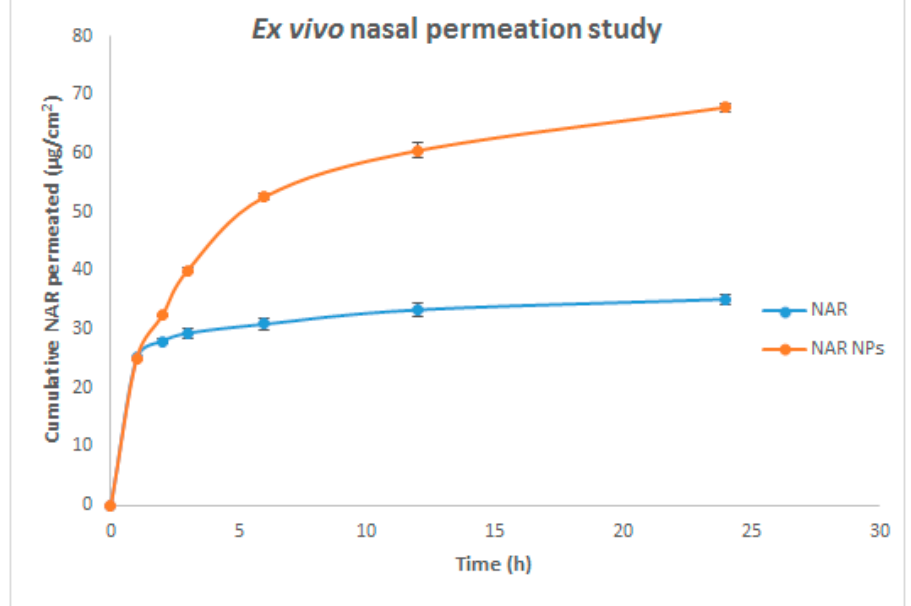
Figure 5. Ex vivo nasal permeation of NAR NPs and NAR solution in in PBS at pH 7.4. Values are expressed as mean ± SD ( n = 3), three independent experiments performed in triplicate.